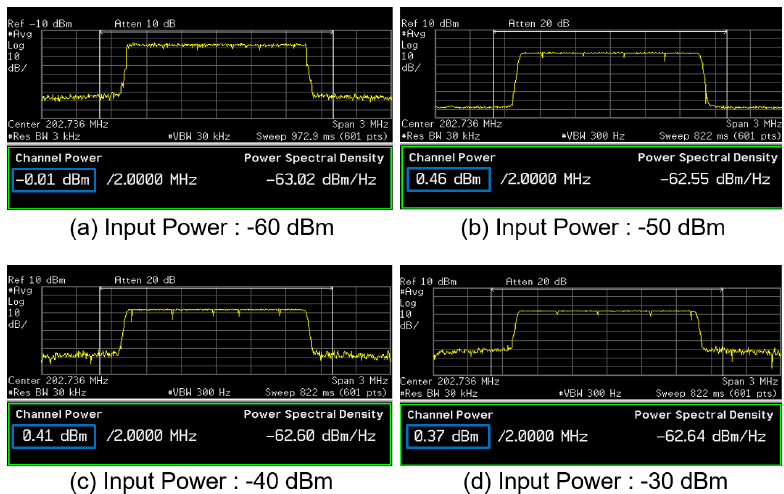
Figure 16. Output DMB signals when different input power levels are